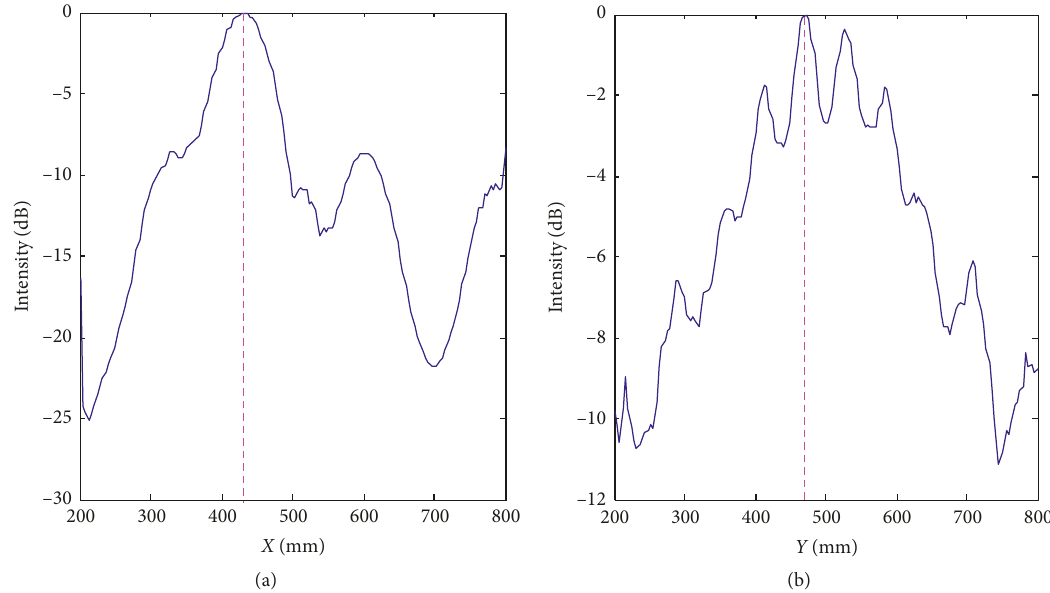
Figure 6: SAFTimaging intensity profile in (a) the X direction of the point (432 mm, 471mm) and (b) the Y direction of the point (432 mm, 471